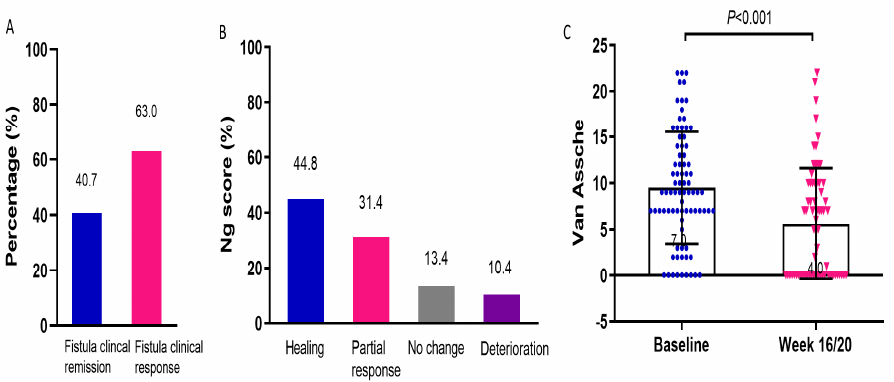
Figure 3. Efficacy of UST on perianal fistula. ( A ) Fistula clinical remission and response rates determined by PDAI, n = 108. ( B ) Radiological outcomes evaluated by Ng score, n = 67. ( C ) Changes in Van Assche scores before and after UST therapy, n = 67. UST: ustekinumab; PDAI: perianal Crohn’s disease activity index.